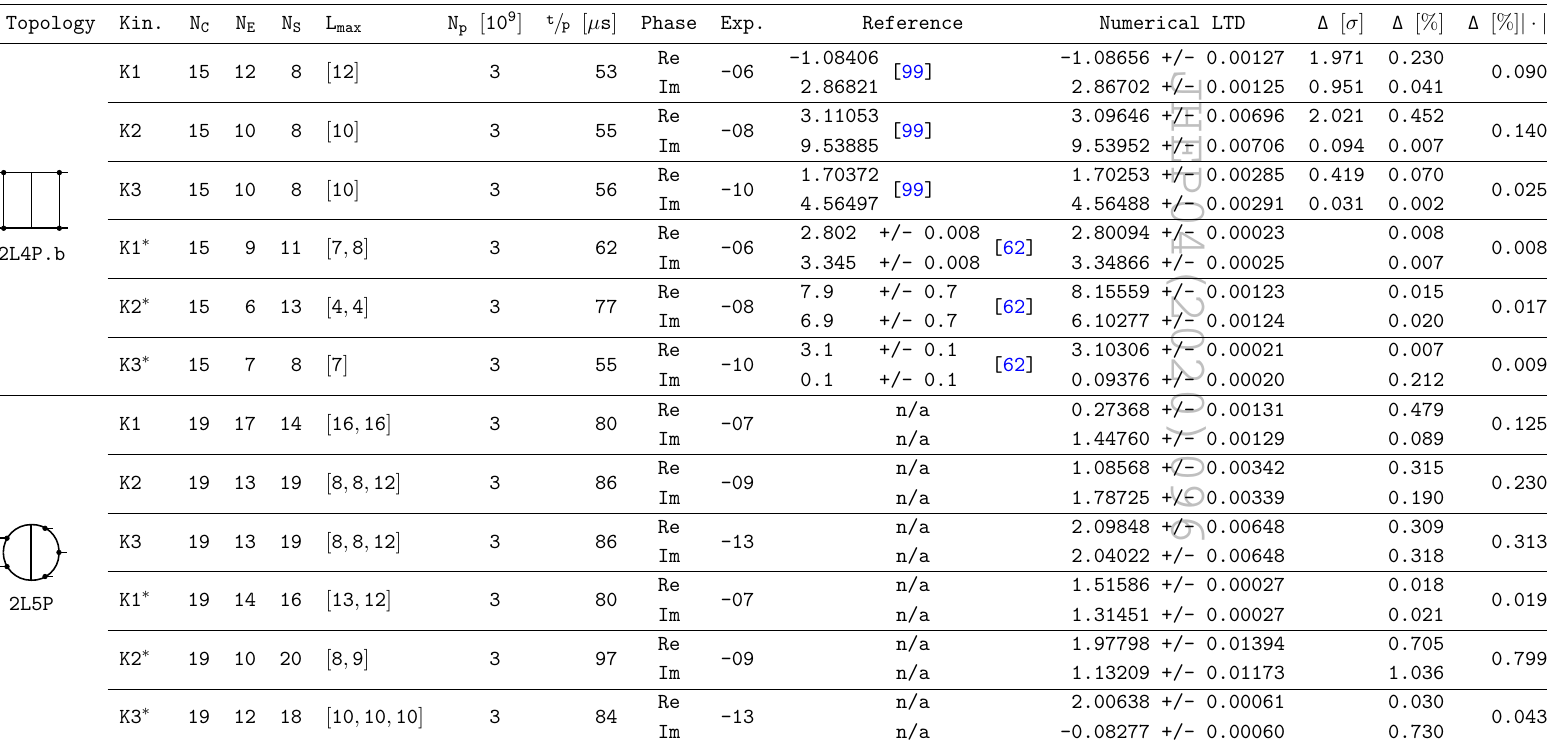
Table 6. Results for two-loop topologies for scattering kinematics (2